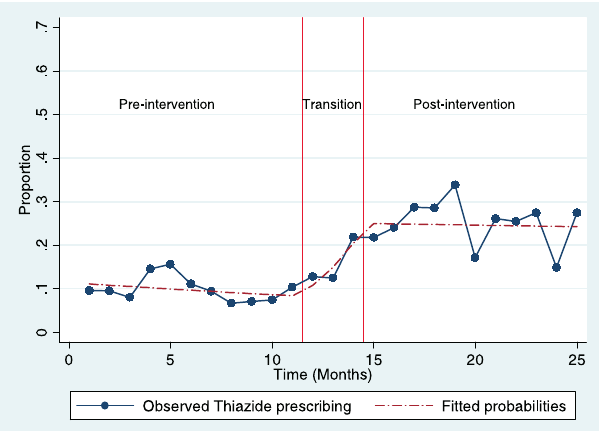
Figure 2. Proportion of Thiazide Prescriptions among All Prescriptions for Patients Started on Treatment for Uncomplicated Hypertension